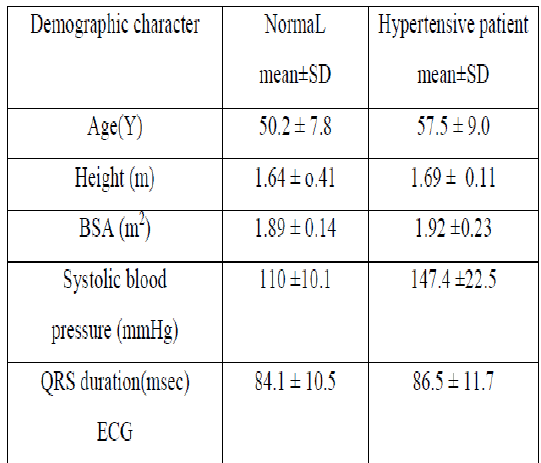
(Table 1): The distribution of studied groups according to their demographic characters